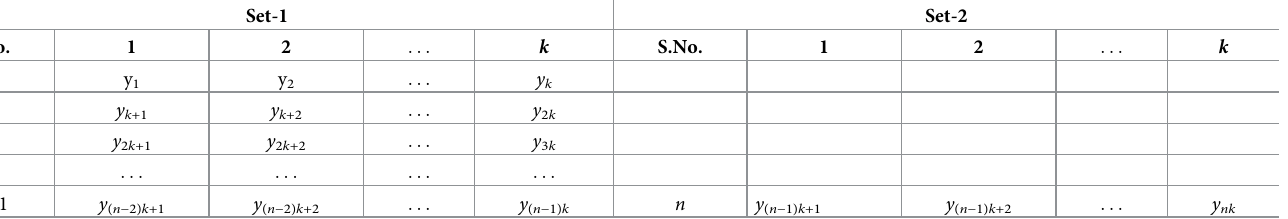
Table 1. Layout of the population